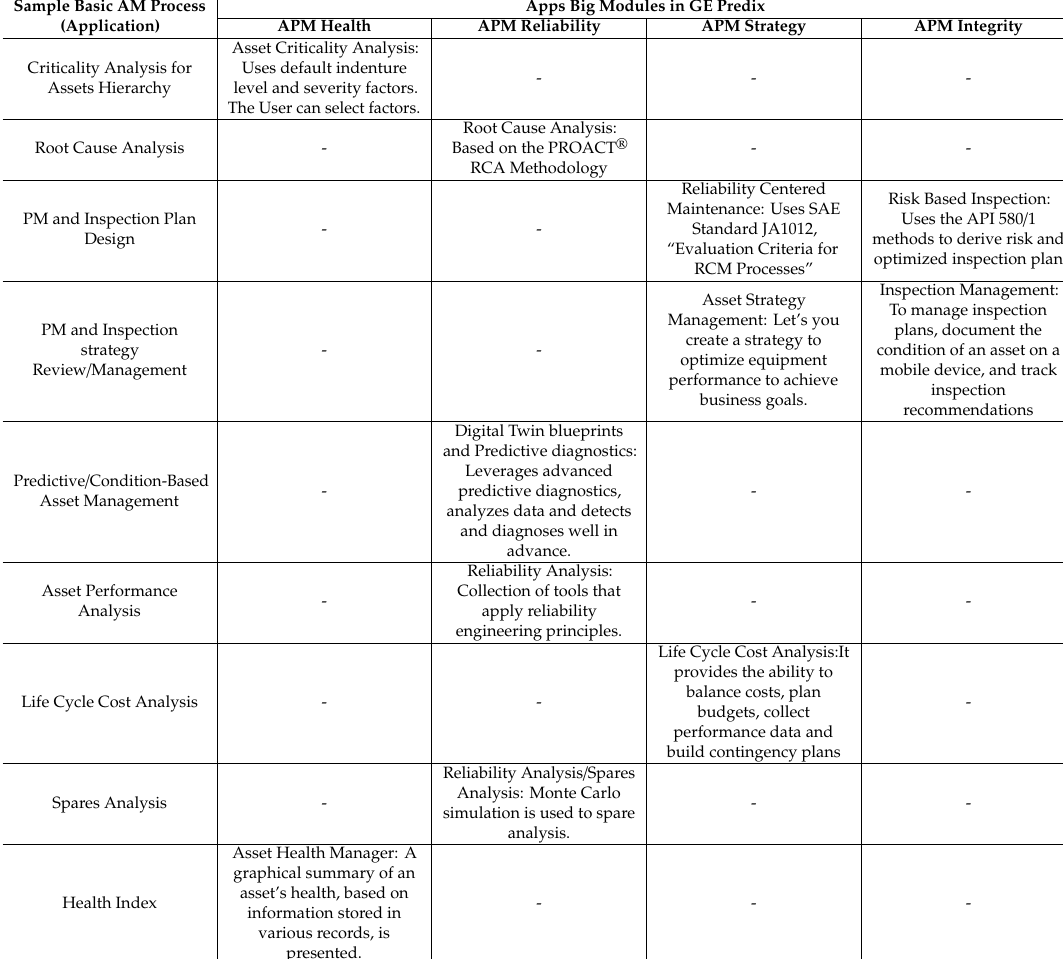
Table 1. Correlation of business AM basic processes with Predix Platform